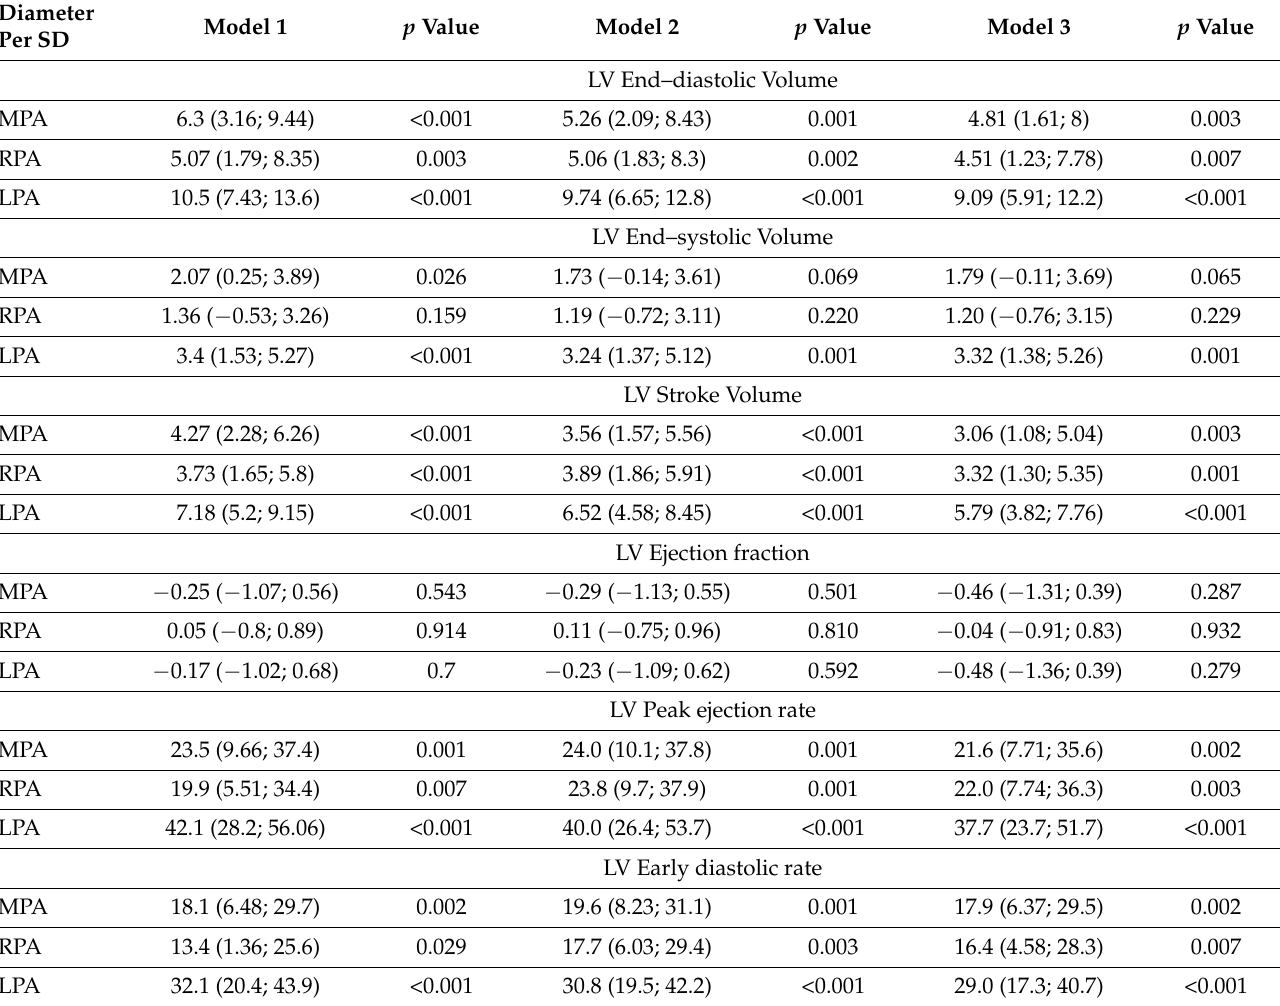
Table 3. Association between diameter of the pulmonary artery and ventricle